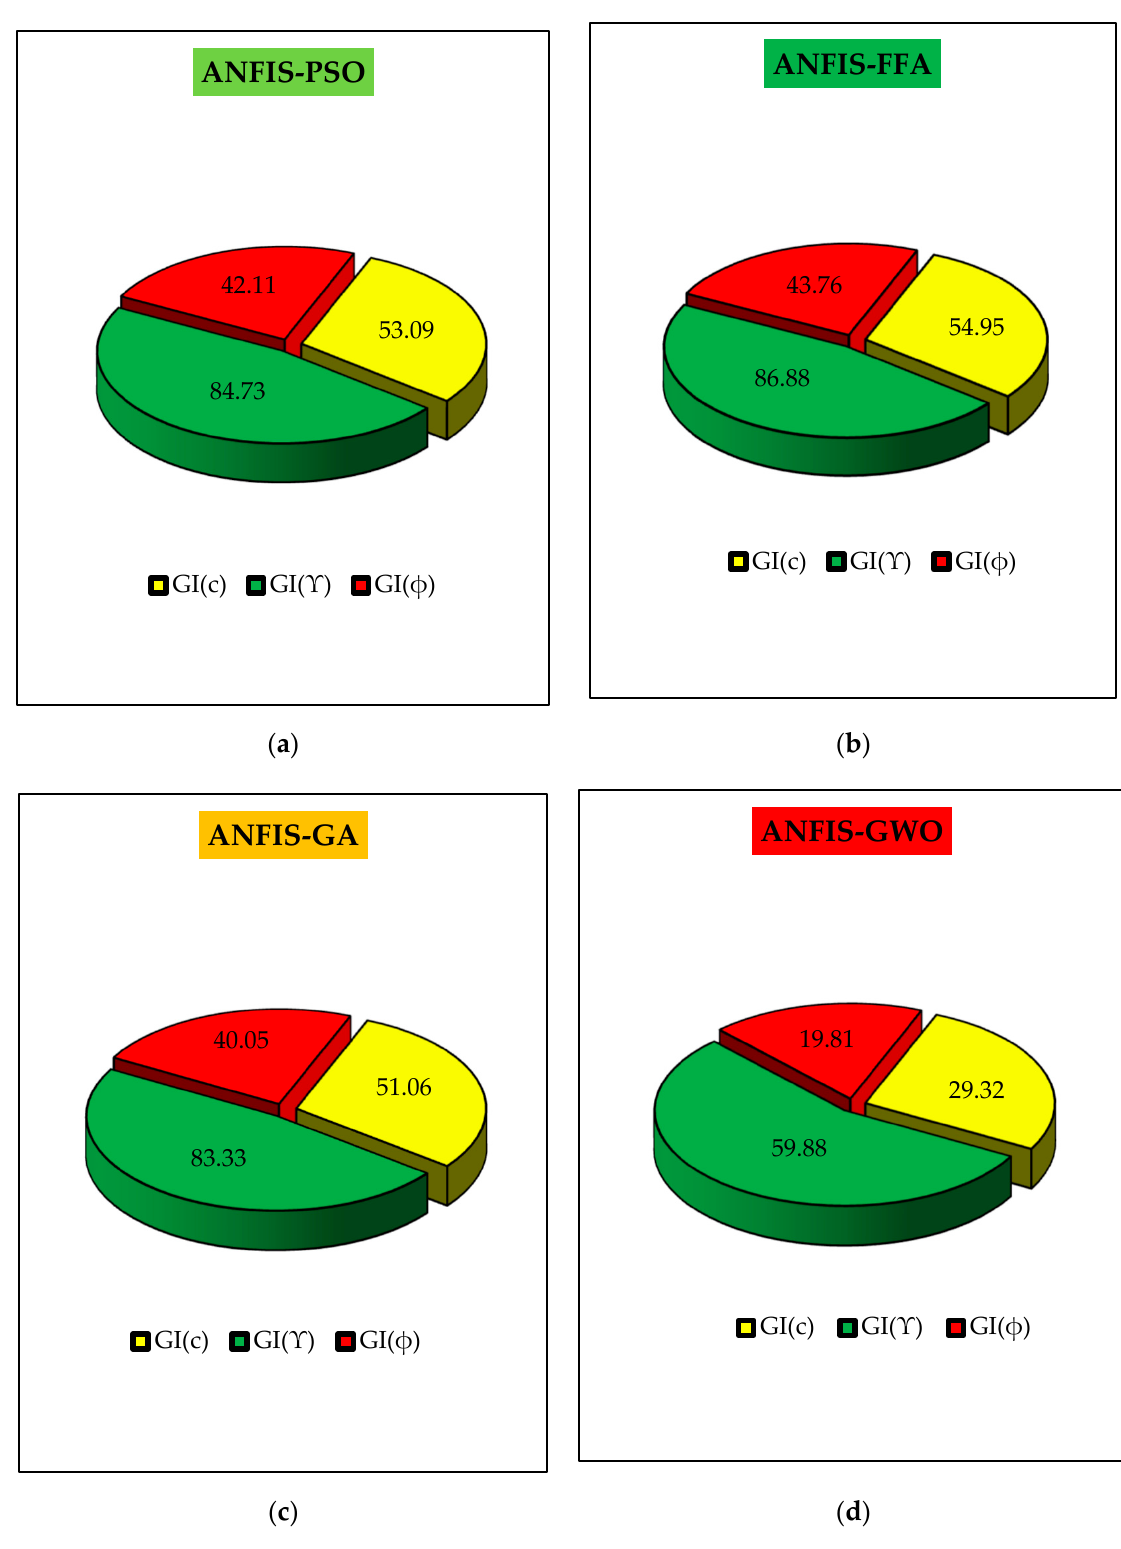
Figure 12. The relative significance of input variables for ( a ) ANFIS-PSO, ( b ) ANFIS-FFA, ( c ) ANFIS- GA and ( d ) ANFIS-GWO model.